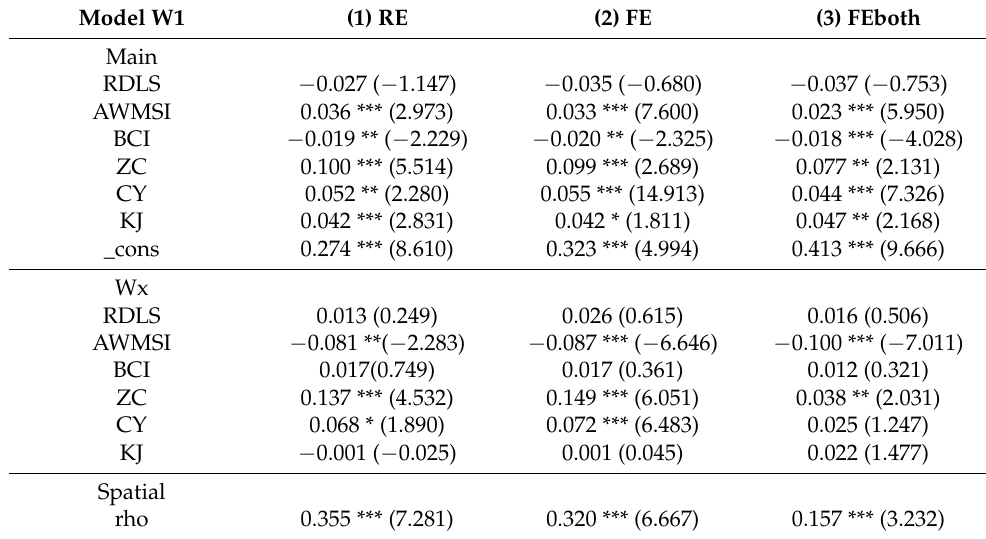
Table 8. Spatial Durbin model results with W1.